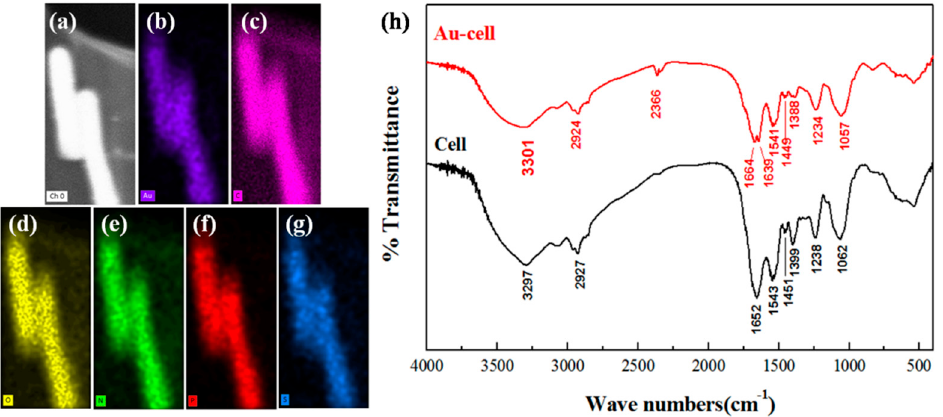
Figure 2. ( a ) SEM image of B. licheniformis FZUL-63 after interaction with gold; ( b–g ) elemental maps of Au, C, O, N, P, and S, respectively; ( h ) Fourier transformed infrared spectra of B. licheniformis FZUL-63 biomass: before and after gold uptake (initial concentration of 200 mg Au (III) L − 1 at pH 6.0, time 1 h).